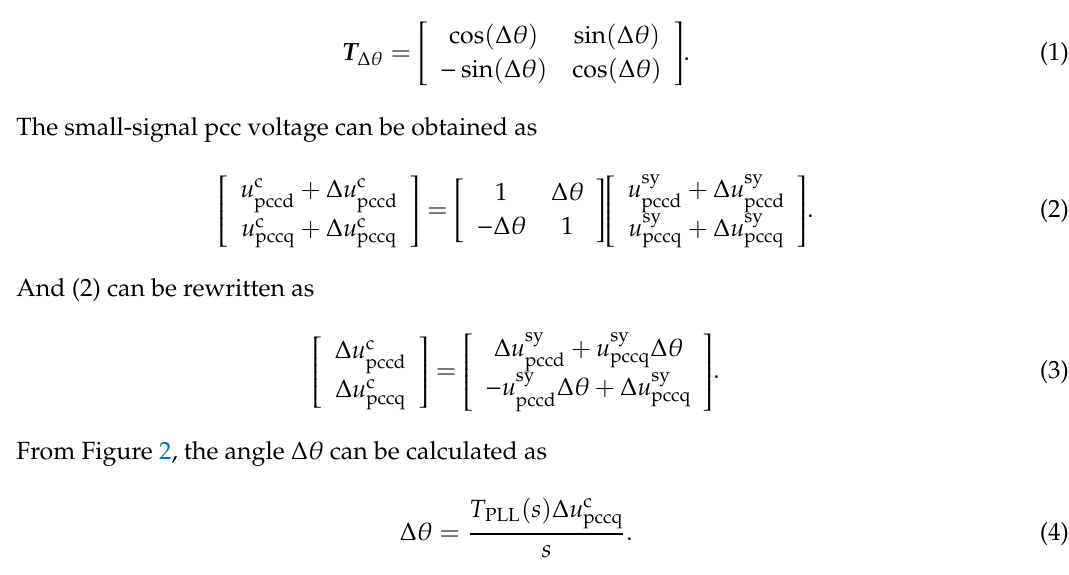
Figure 3. The dq admittance model of traditional control method.